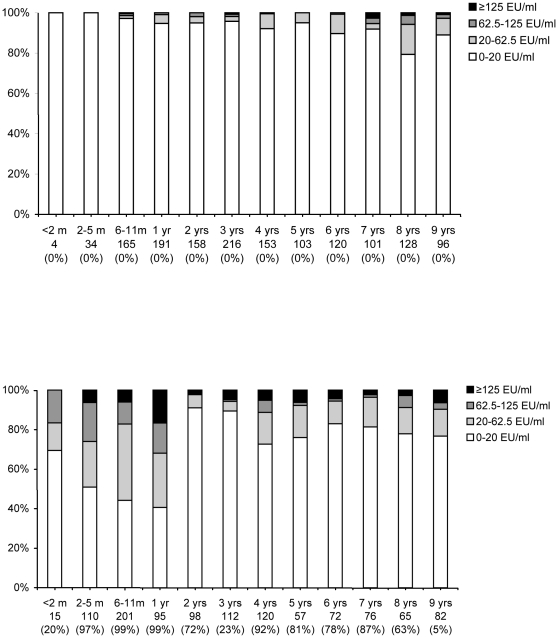
Age-specific seroprevalence of IgG-Ptx concentrations in children 0–9 years of age in 1995-96 (upper figure) and in 2006-07 (lower figure).Note: on the x-axis the age-group, number tested and in brackets the percentage targeted by the acellular vaccine are indicated. In 2006-07 children below 4 years of age could have been primed with either whole-cell or acellular vaccine in infancy (nationwide coverage circa 96%), and children 4–9 years of age could have been primed with whole-cell vaccine and may have received a preschool booster with acellular vaccine (nationwide coverage circa 90%).